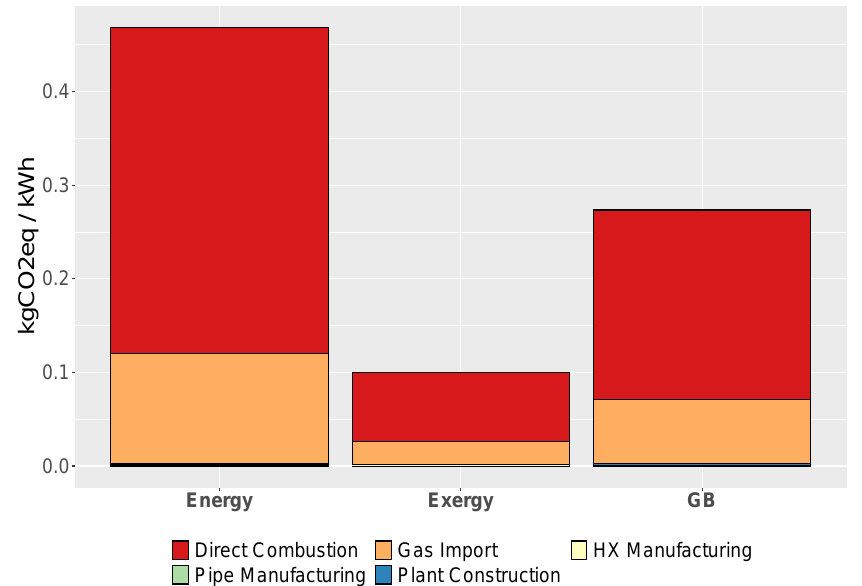
Figure 2. Specific emissions for DH with allocation methods and for GB.